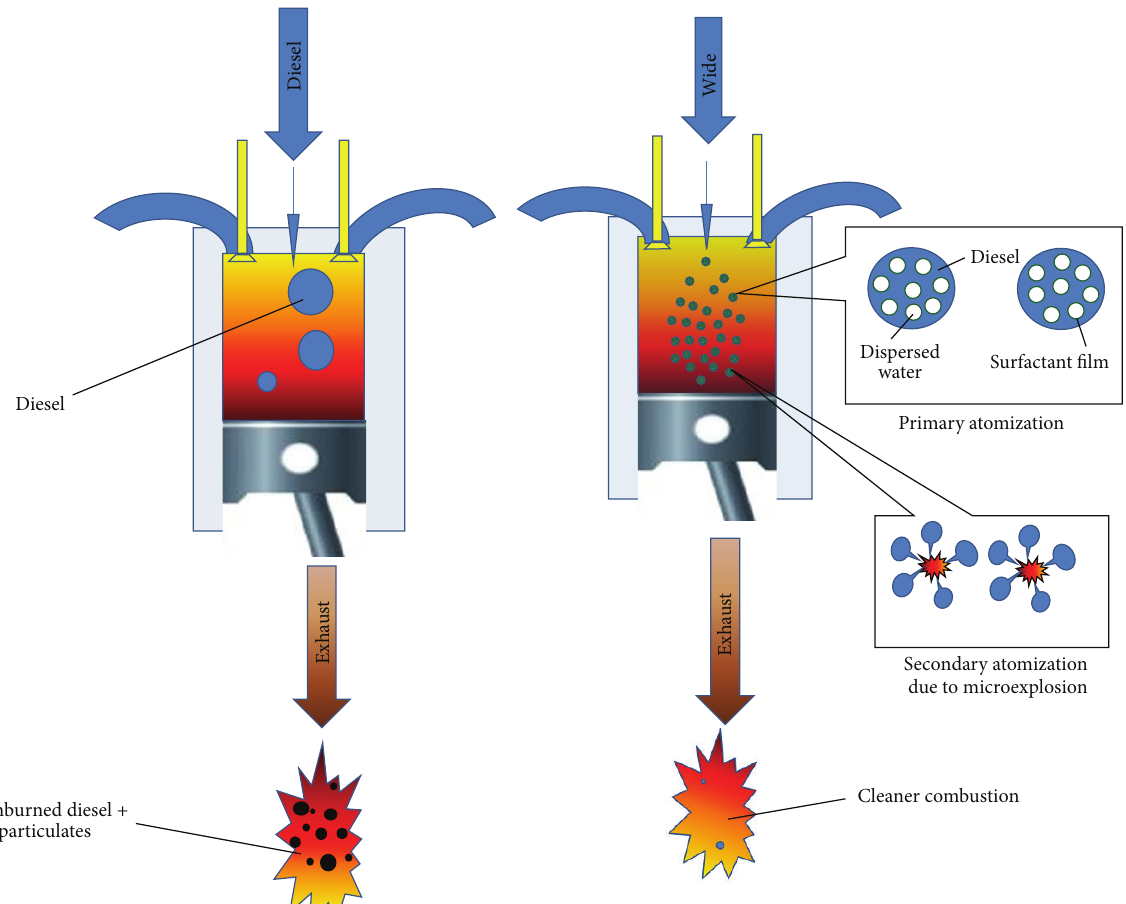
Figure 3: Primary and secondary atomisation in spray flame of emulsified